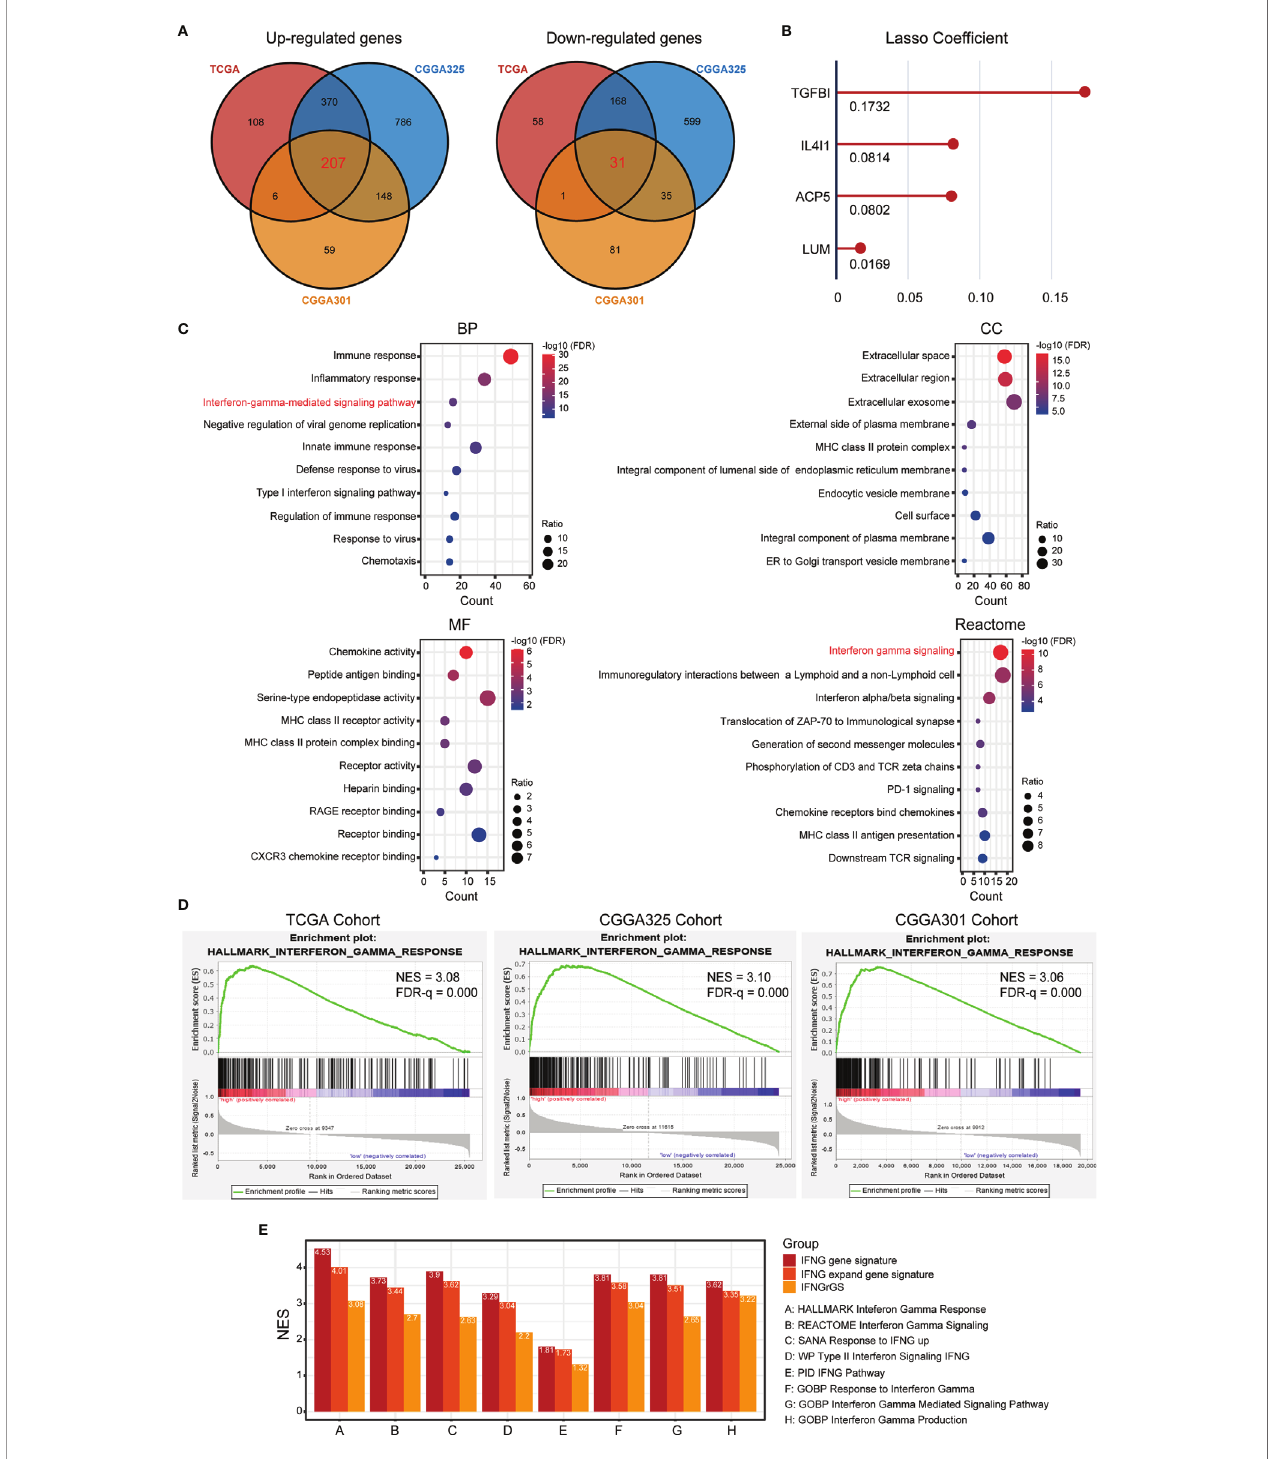
FIGURE 1 | Identi fi cation of the IFNG-related gene signature (IFNGrGS) and construction of the IFNGrGS-based strati fi cation. (A) Venn diagrams of signi fi cantly up- regulated and down-regulated DEGs across 3 data sets. (B) The signature genes and corresponding regression coef fi cients estimated by LASSO. (C) Functional enrichment analysis of the 238 DEGs, including BP, CC, MF, and Reactome pathway. (D) GSEA analysis of the hallmark interferon-gamma signaling pathway, IFNGrGS score-high group vs. IFNGrGGS score-low group. (E) Comparison of the ef fi cacy of our IFNGrGS with previously established pan-cancer-based IFNG gene signature and IFNG expand gene signature in characterizing the IFNG response based on the TCGA cohort. NES was calculated using GSEA